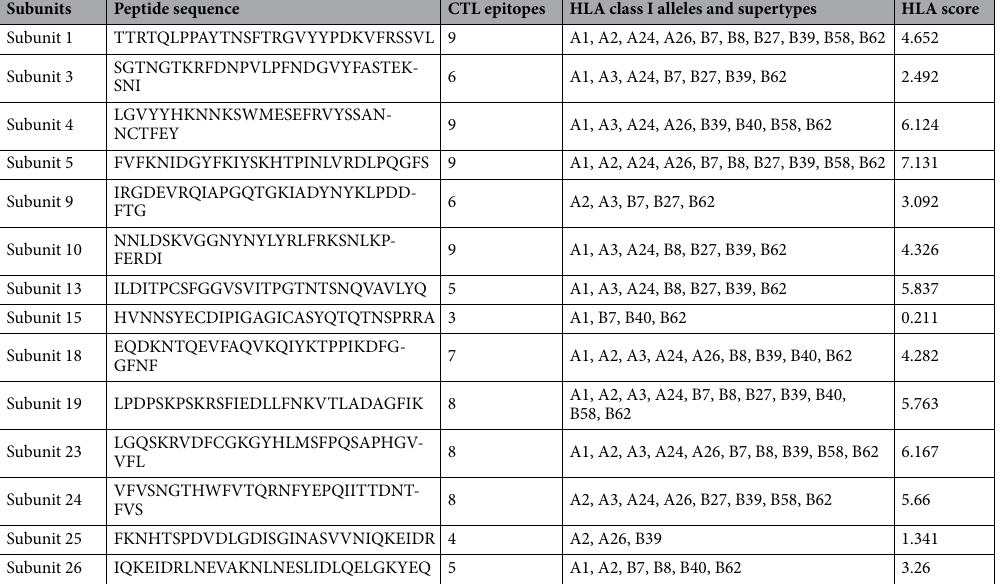
Table 6. CTL epitopes prediction results.